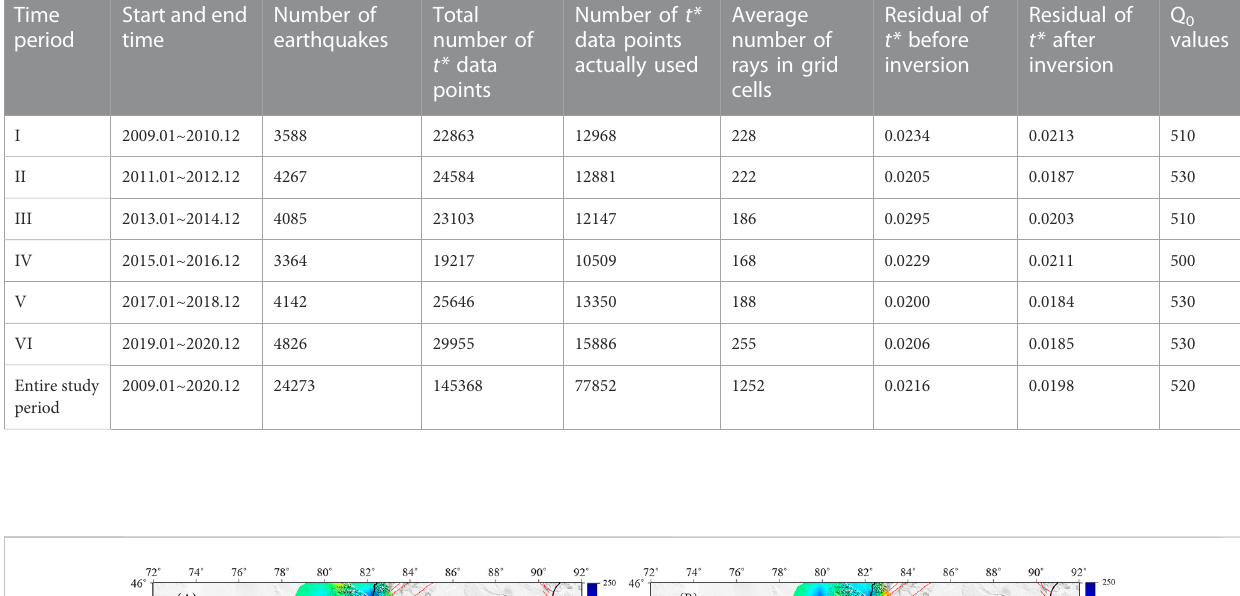
TABLE 1 Data statistics for the six two-year periods (between 2009 and 2020) considered in this study. Time period